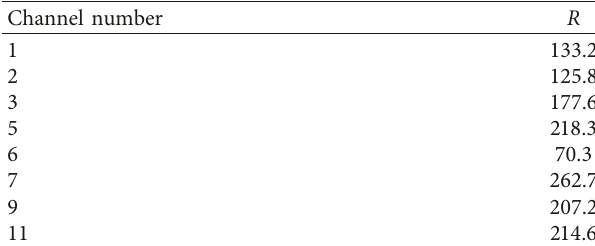
Table 5: Maximum value of circle radius.